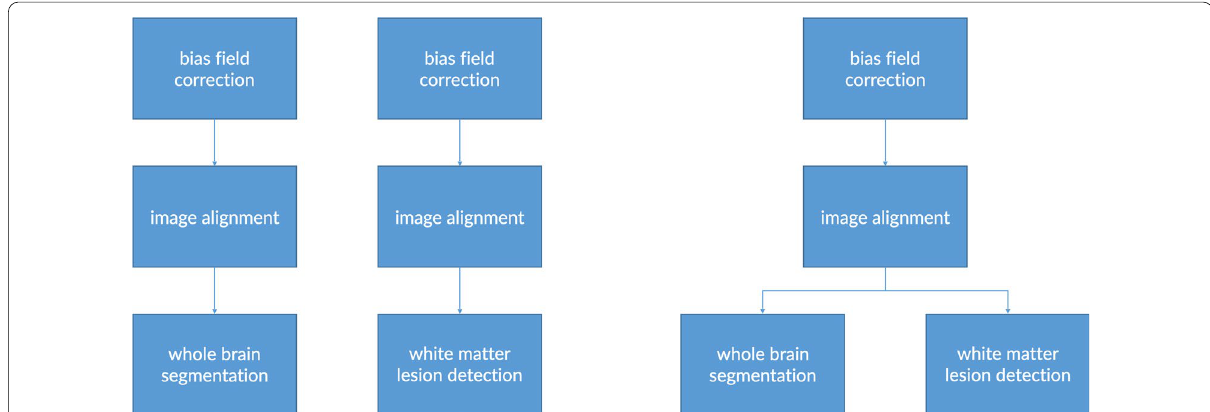
Fig. 2 Illustration of the principle of using a directed acyclic graph (DAG) to efficiently pool common subtasks. Left panel shows a conventional approach with separate pipelines for different tasks (whole brain segmentation and white matter lesion detection). Right panel shows how using a DAG facilitates a more efficient approach that can accomplish the same end result by pooling common